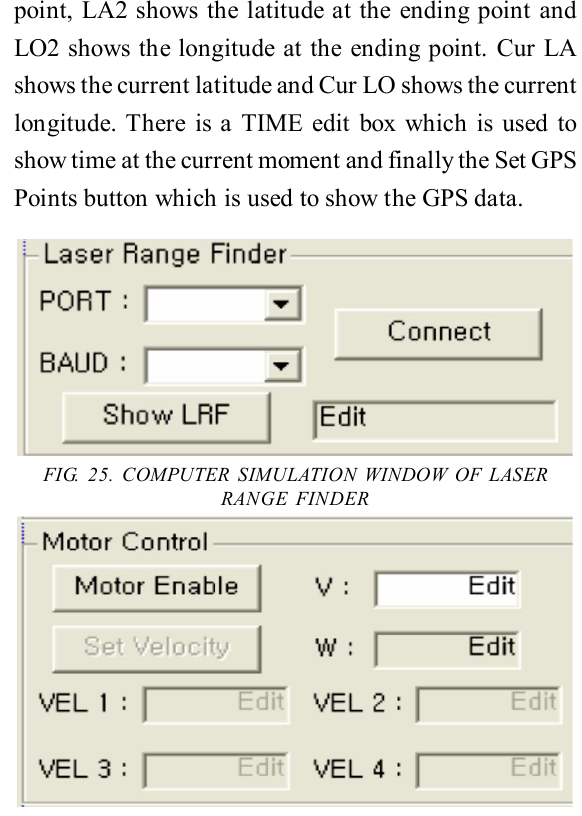
FIG. 26. COMPUTER SIMULATION OF MOTOR